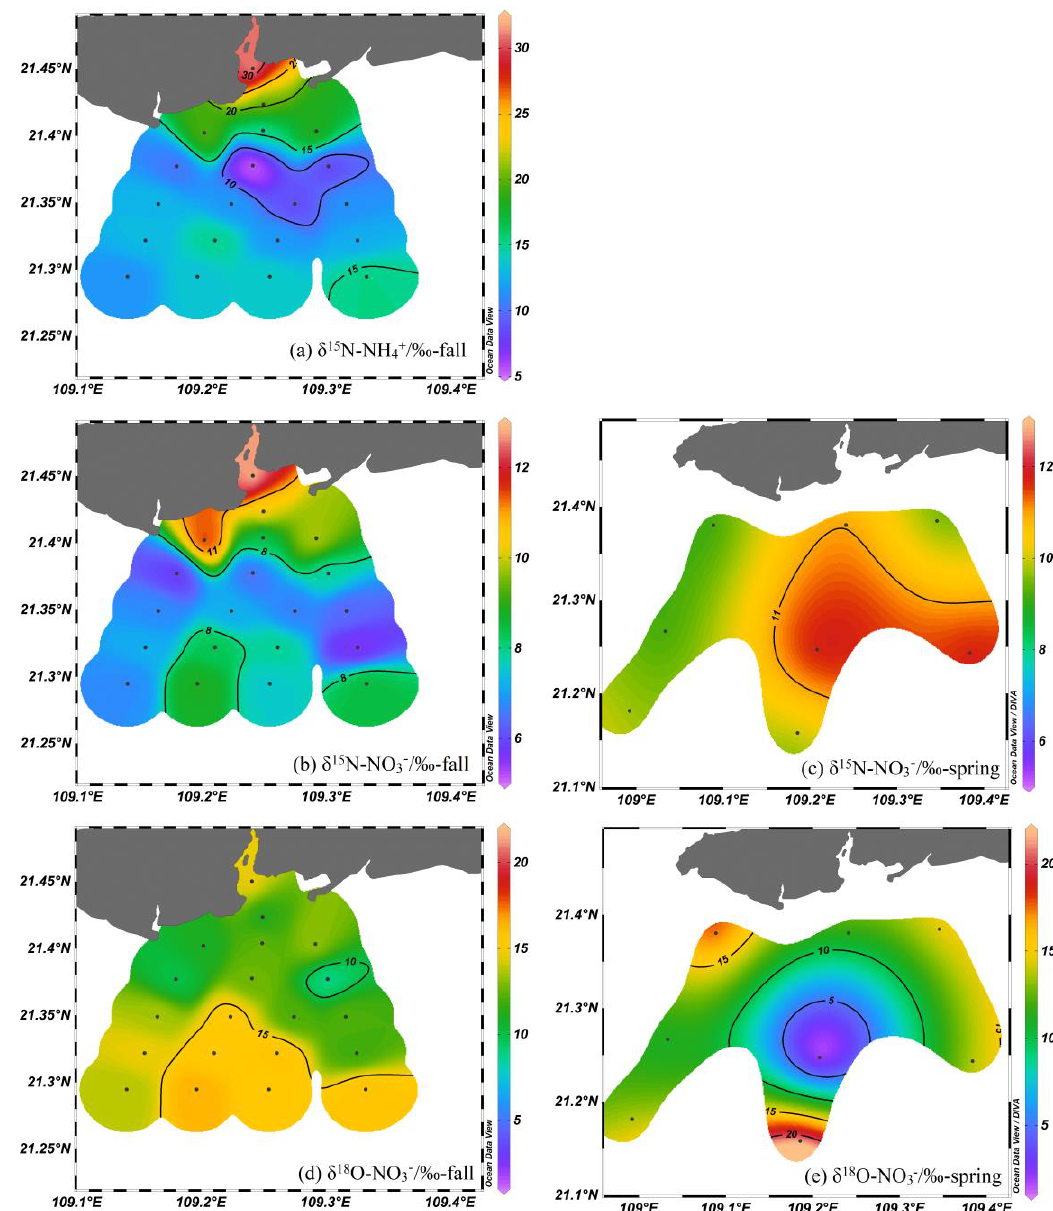
Figure 4. Spatial distributions of ( a ) δ 15 N-NH 4+ , ( b , c ) δ 15 N-NO 3 − , and ( d , e ) δ 18 O-NO 3 − during the different seasons in the north-eastern Beibu Gulf, China.